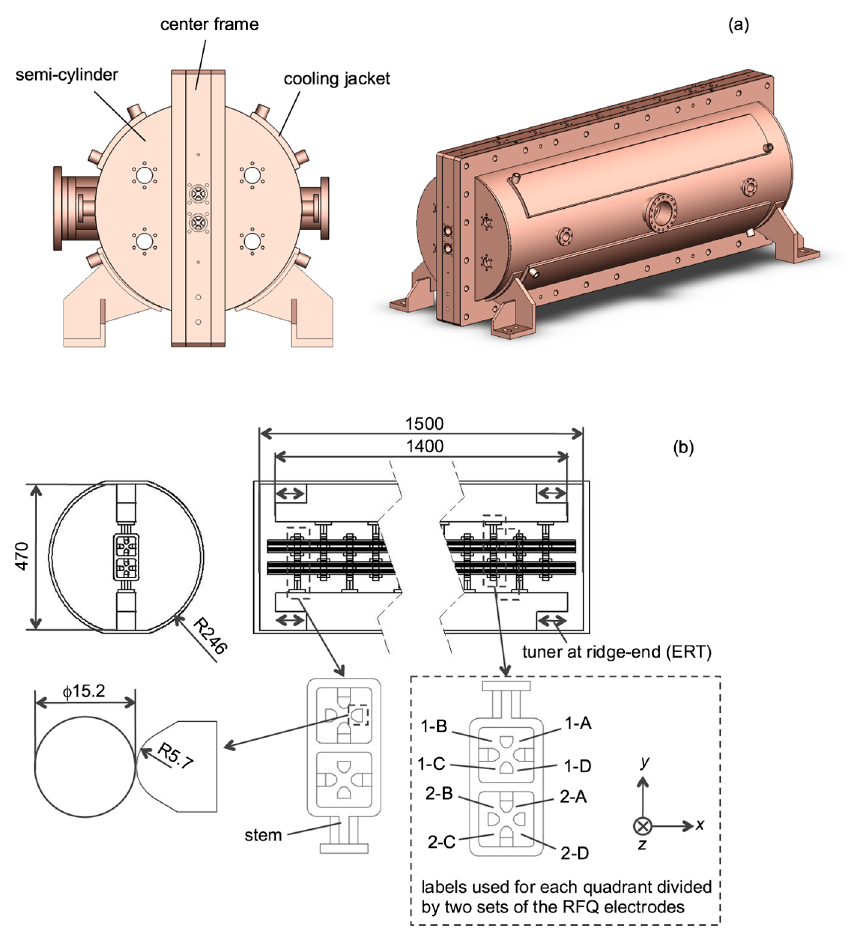
FIG. 1. Schematic diagram of the two-beam IH-RFQ cavity: (a) external view; (b) cross-section view.